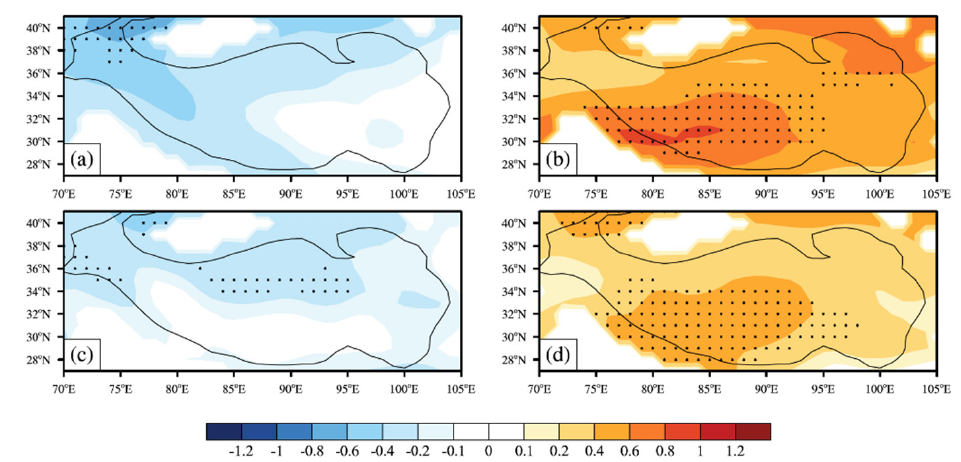
Figure 10. Trends of the 400 hPa (top) and 500 hPa (bottom) wind speed (units: m s − 1 decade − 1 ) over the TP during 1979–2017. ( a , c ) are in spring (March–May), while ( b , d ) are in winter (December–February). The black contour denotes the isoline of 3000-m elevation. The dots indicate significant trends at 95% confidence level using the student- t test.